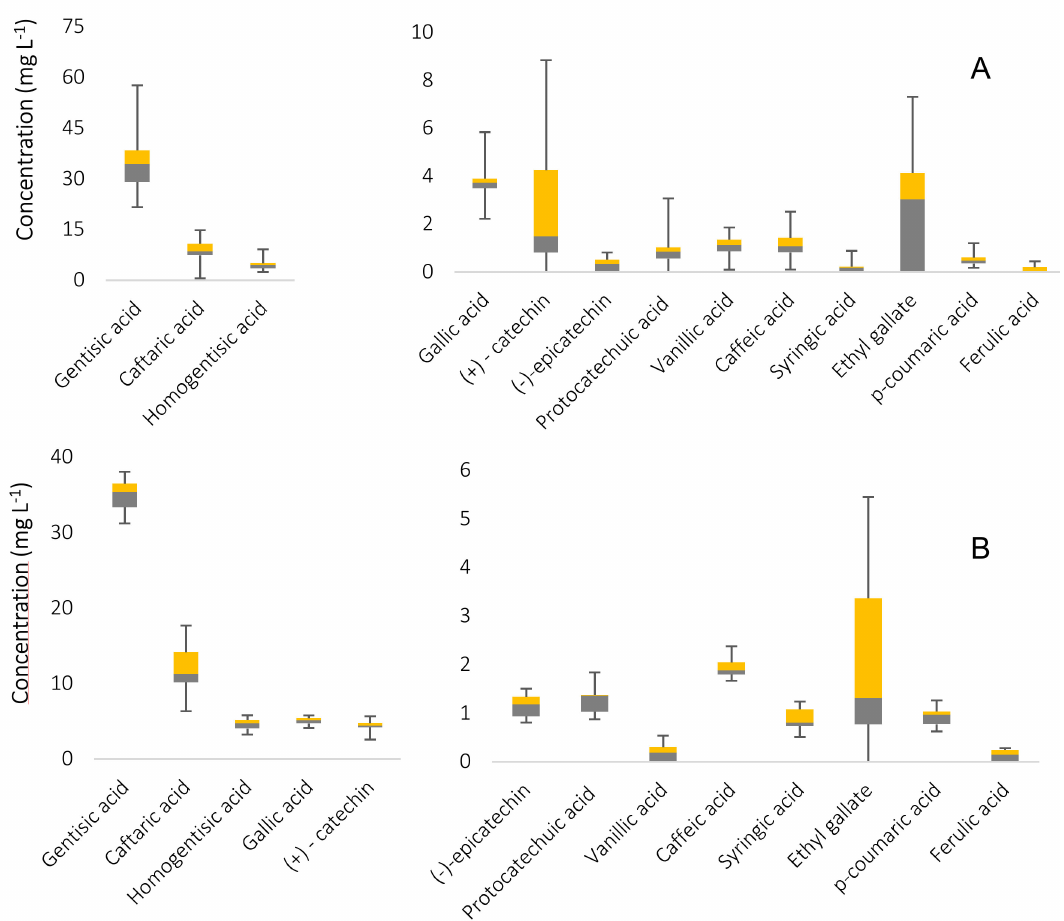
Figure 2. Boxplots with whiskers with the polyphenolic composition of the sets of ( A ) white and ( B ) ros é cava samples under study. Error bars indicated the variability in the concentration